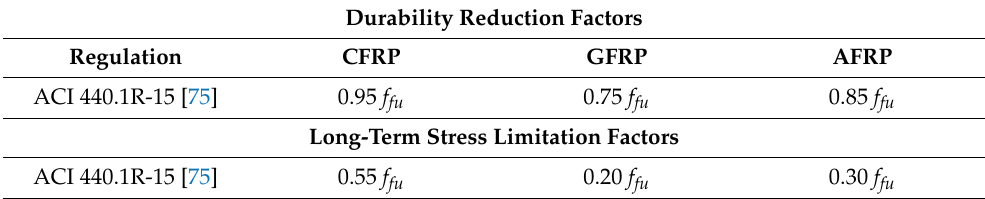
Table 7. Reduction factors and long-term stress limitation